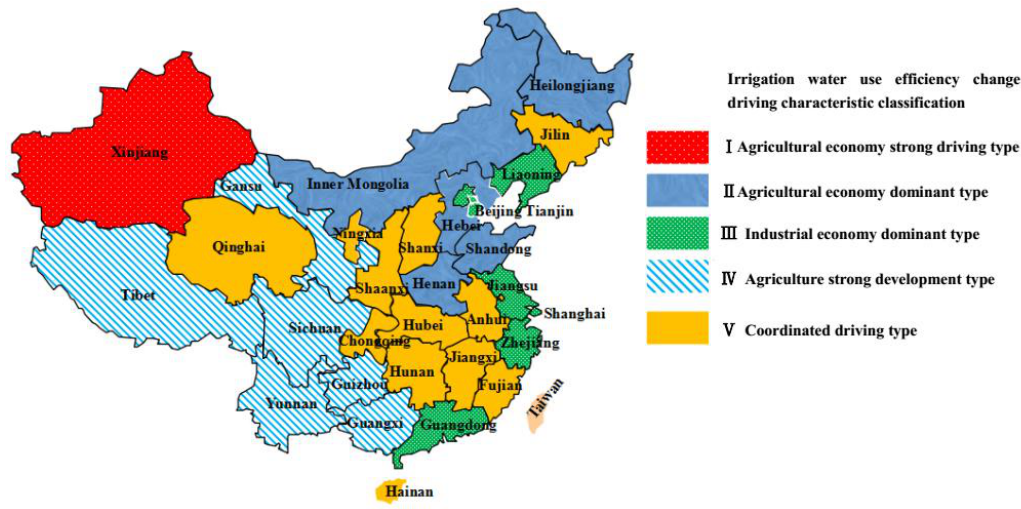
Figure 1. Irrigation water-use efficiency change driving characteristic classification for each province in China in 2009.